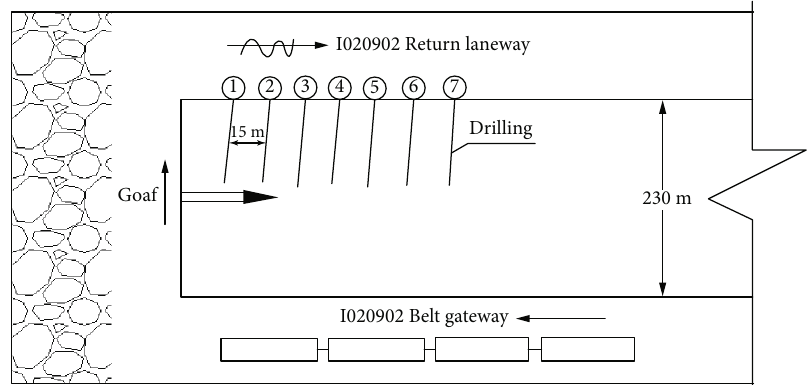
Figure 1: Arrangement of drilling for water injection and dedusting in